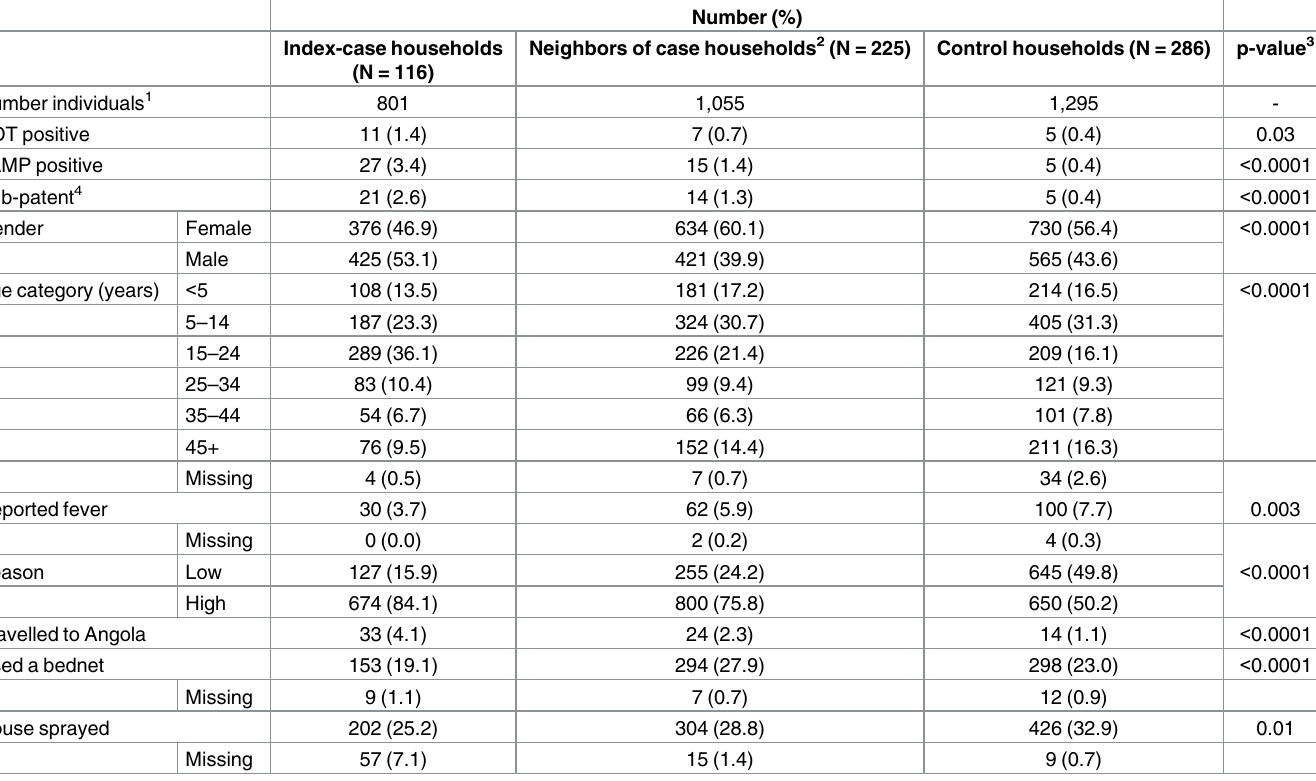
Table 2. Characteristics of individuals screenedfor malaria in case and control neighborhoods by RDT and